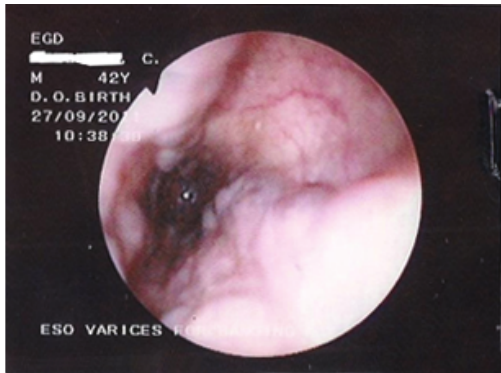
Figure 1: Endoscopy of esophagus showing the grade 1 (enlarged but straight)